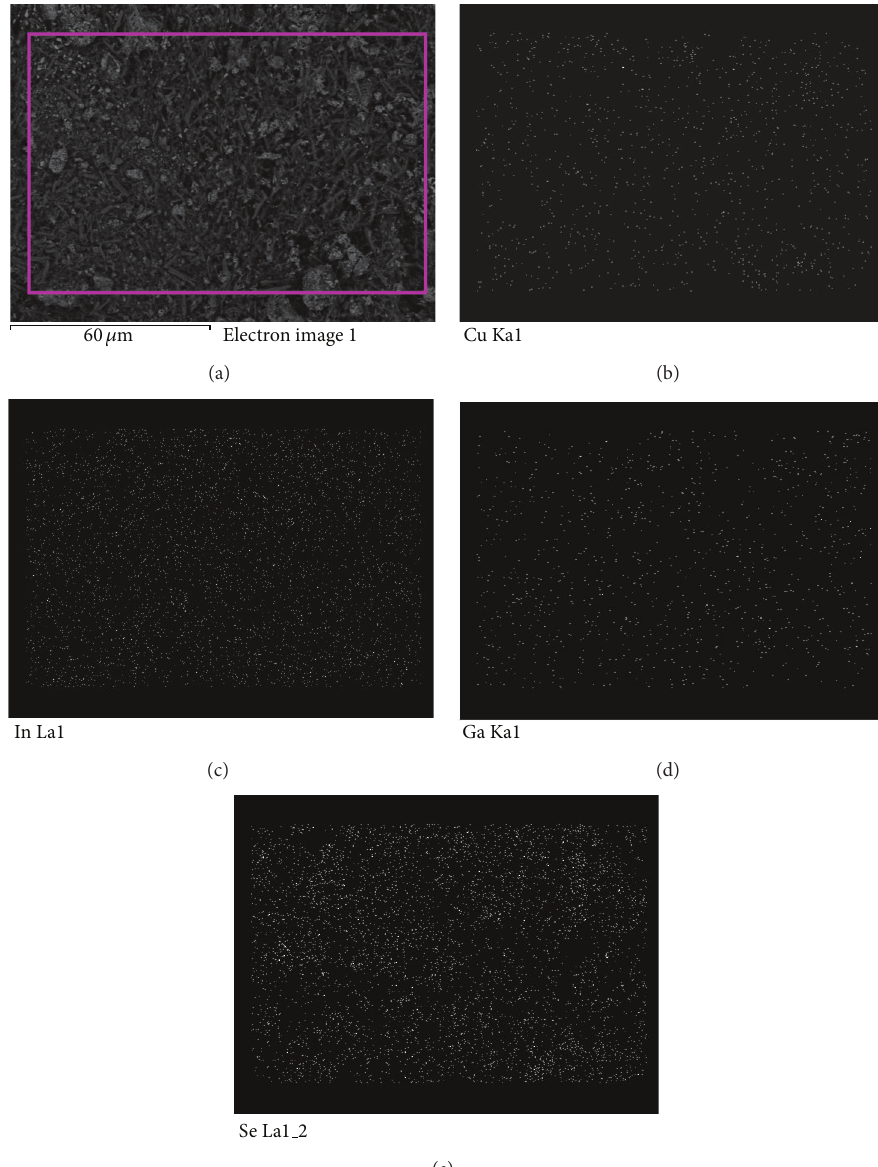
Figure6:(a)SEMimageandcorrespondingcompositionalmappingof(b)Cu,(c)In,(d)Ga,and(e)SeoftheCIGSfilmpreparedat − 1350 mV via